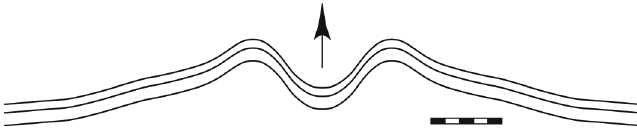
Fig. 60. Lituites dewitzi sp. nov. from the Schroeteri Limestone; lirae on the venter in holotype MB.C.30538 (Neben Coll.) from Boltenhagen near Gross Klütz Höved (Mecklenburg-Vorpommern, Germany), at wh = 11 mm. Scale bar units = 1